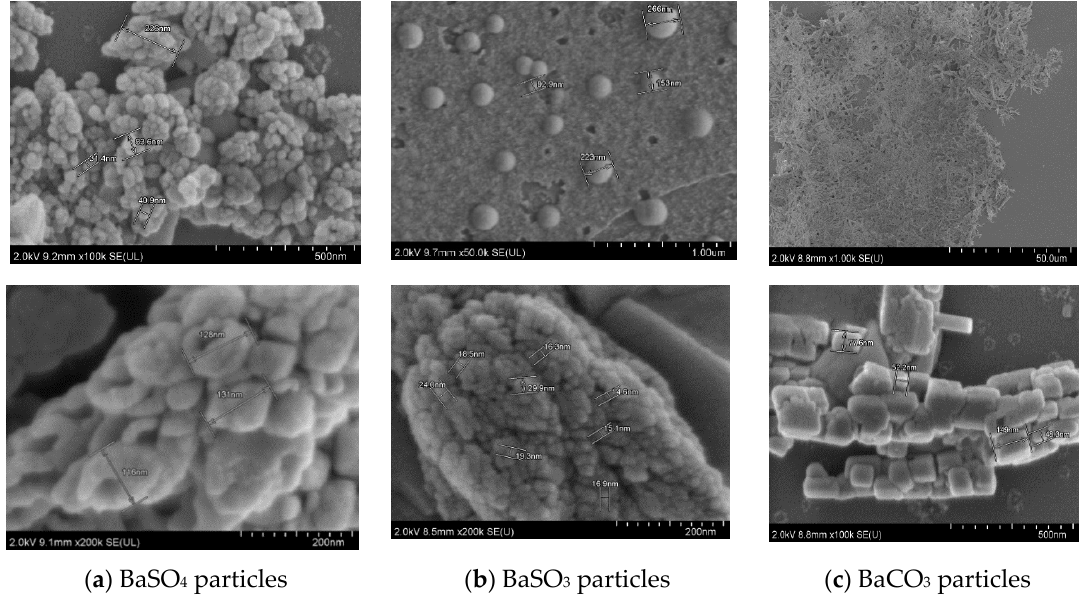
Figure 7. FE-SEM pictures of Ba salt particles. ( a ) BaSO 4 particles show distinctive irregular, oval to hollow rounder shape with particle size between 30–150 nm; ( b ) BaSO 3 particles form innate baseball shape particles of a rough surface with particle size between 15–270 nm; ( c ) BaCO 3 particles form rod shape particles with particle size between 50–500